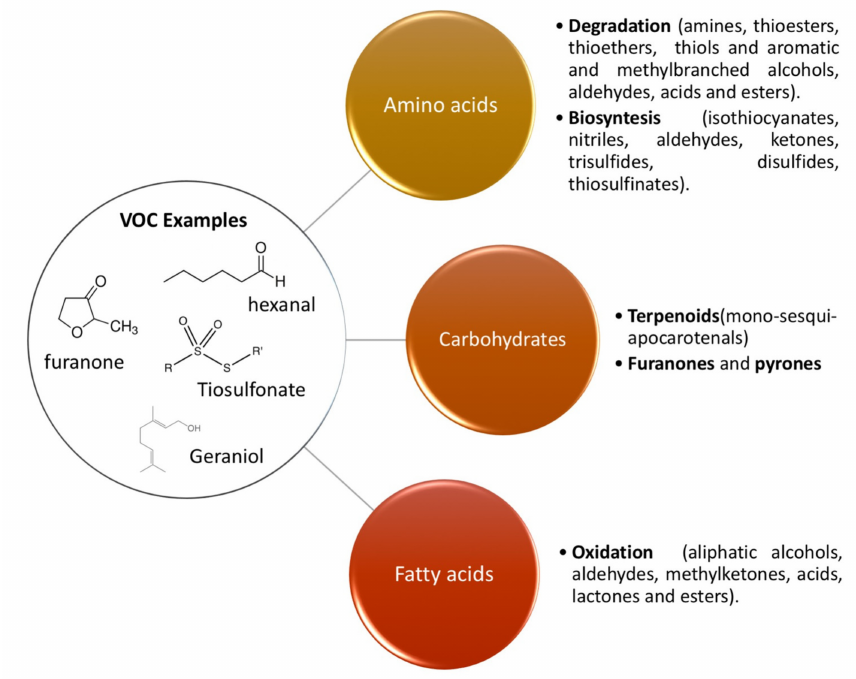
Figure 3. Scheme showing different pathways from the main precursors of nut volatiles